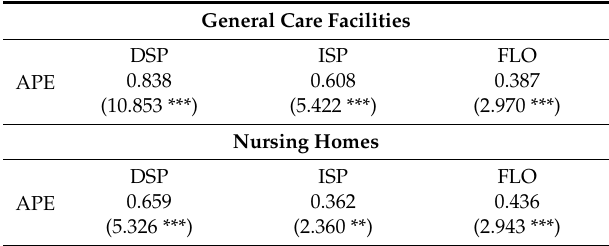
Table 5. Correlation of coefficient.